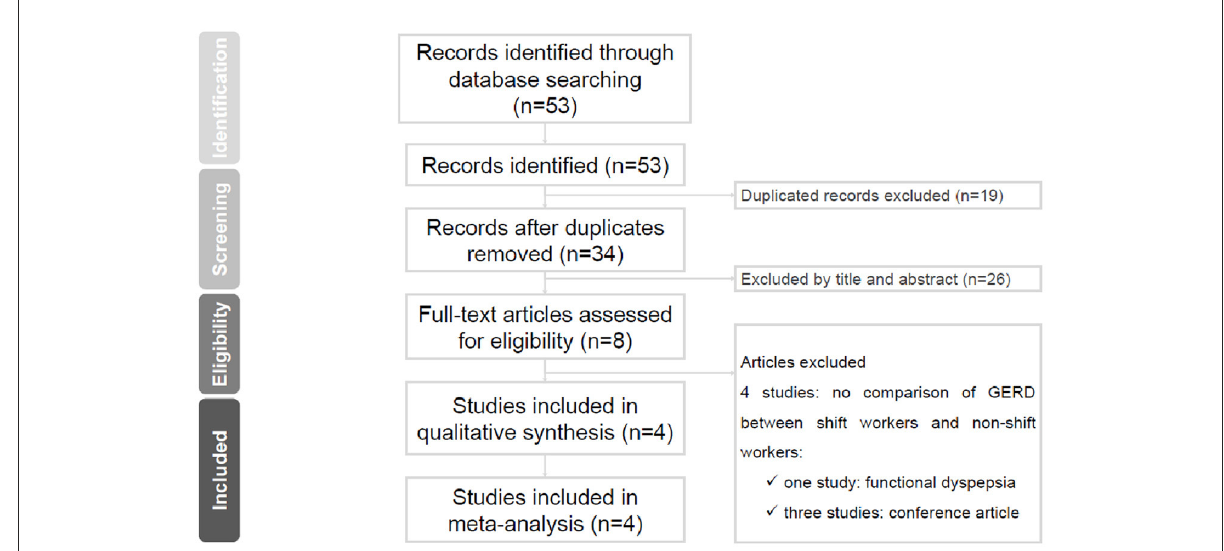
FIGURE1 Preferred reporting items for systematic reviews and meta-analyses flow chart.